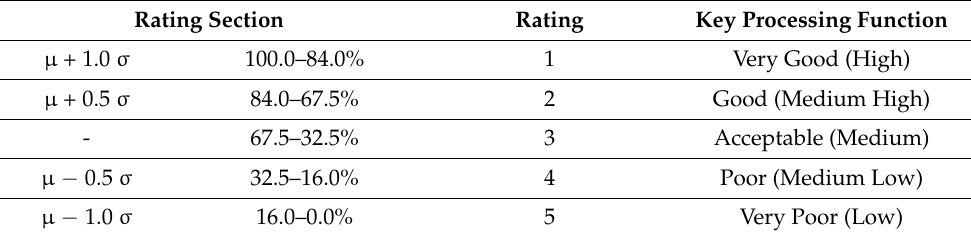
Table 3. Rating section for water social service evaluation.